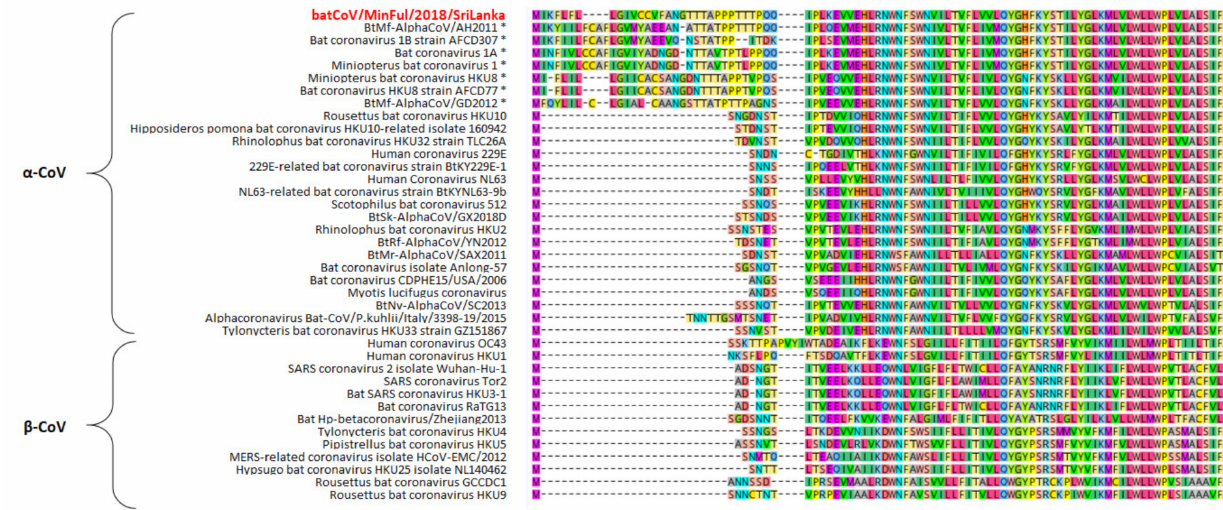
Figure 2. Extract of the first 100 amino acids (aa) of a multiple sequence alignment of the membrane protein from different α -CoVs and β -CoVs, calculated with MAFFT algorithm and visualized in Geneious Prime software with a color code for each aa. The novel strain bat- CoV/MinFul/2018/SriLanka is marked in red. α -CoVs of the subgenus Minunacovirus are marked with an